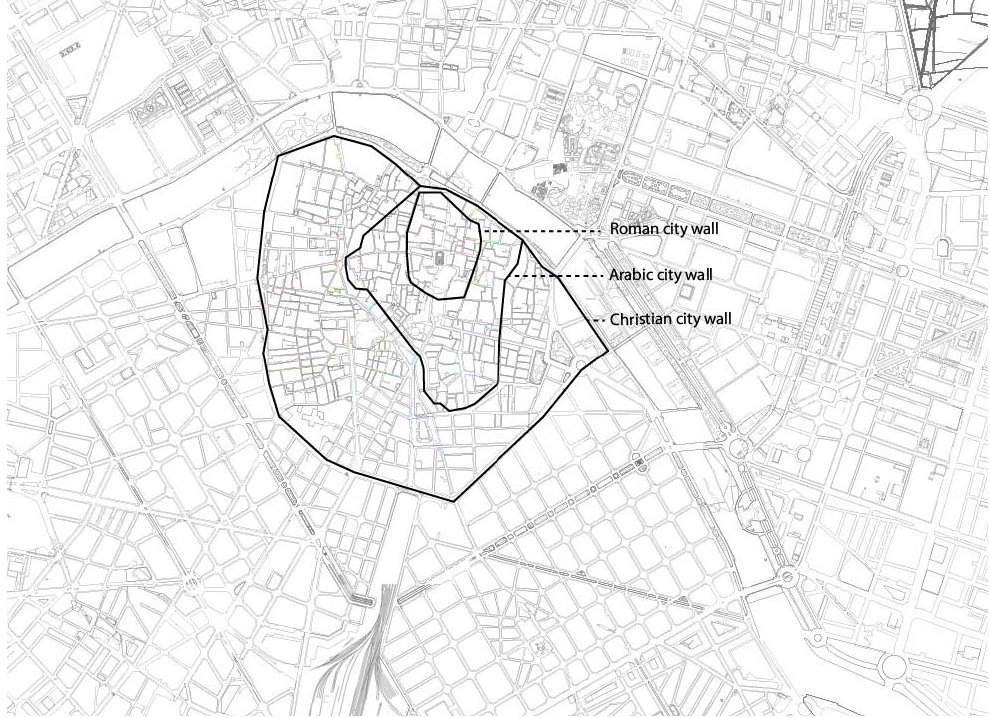
Figure 2. The city walls created by the expansion of Valencia from the roman city to the Christian city.